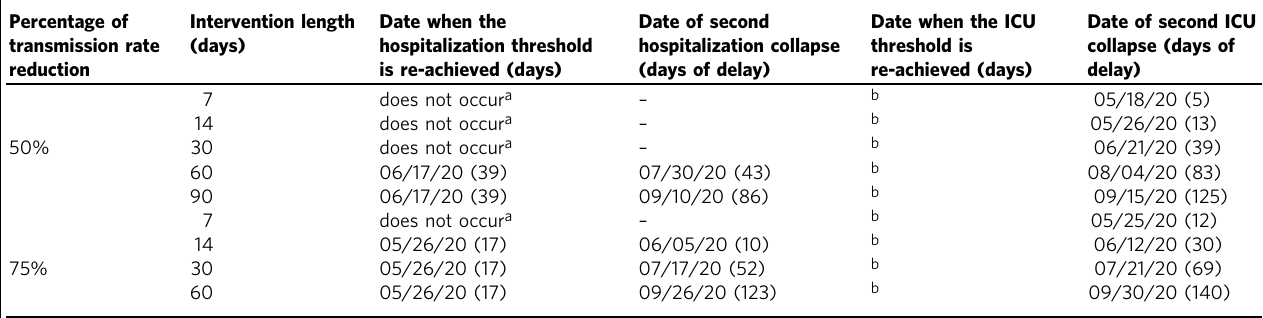
Table 2 Scenarios of critical interventions adopted exactly when total clinical beds availability is reached (05/09/20), with variations of the transmission rate and intervention length.